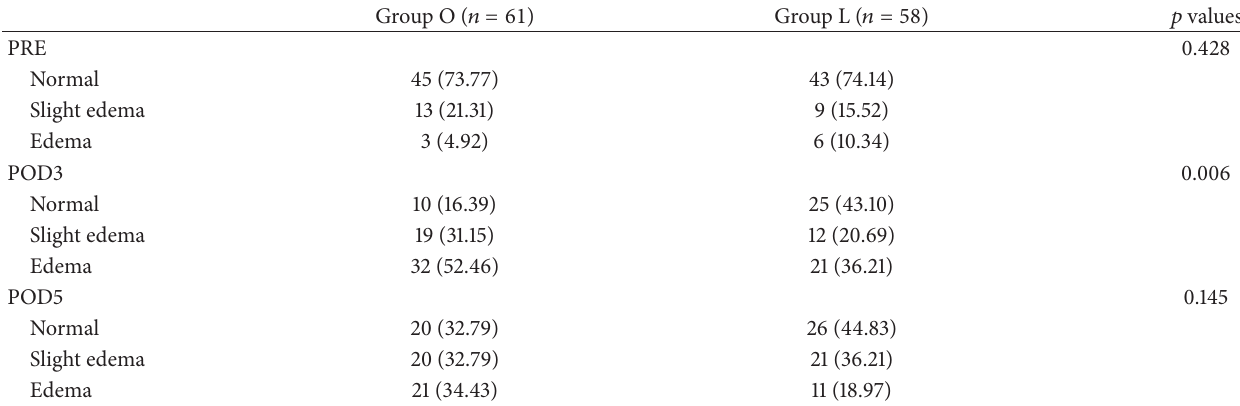
Table 4: Comparison of evolution of edema grades between